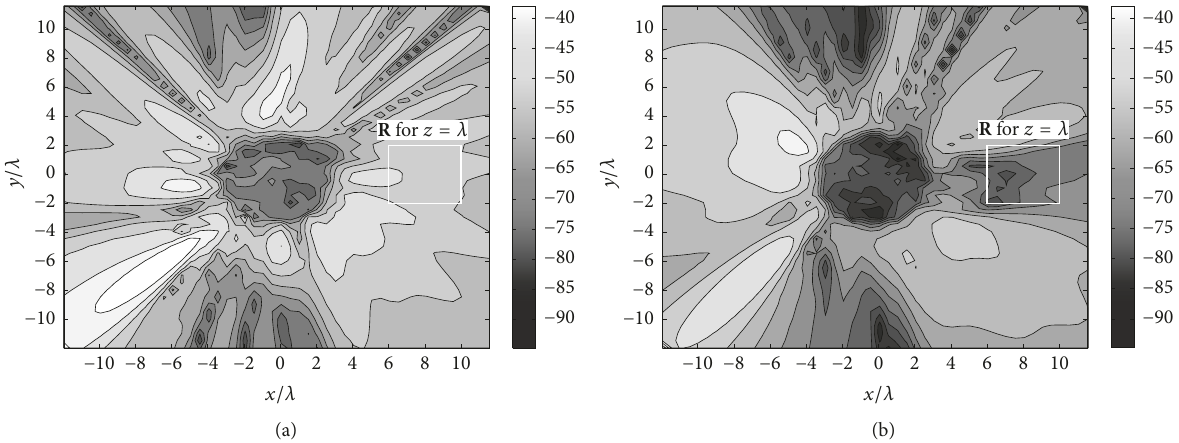
Figure 6: Second application, contour plots of the 2D cuts of the electric near-field amplitude in the worst case ( | E ( a 1 ; r )| for 𝑧 = 𝜆 ): (a) 𝑐 = 𝑐 = 0 ; (b) 𝑐 = 𝑐 = 10 𝐸 𝐷 𝐸 𝐷